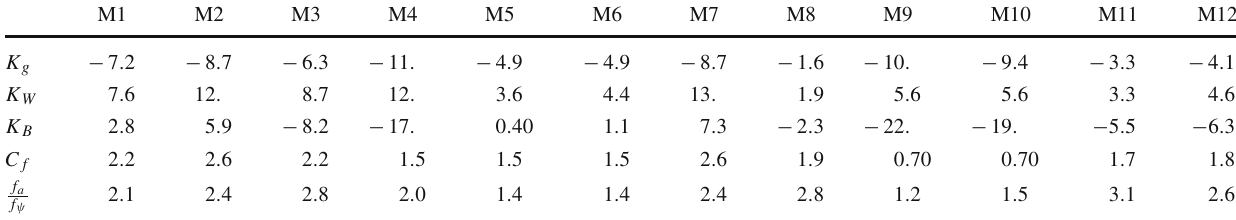
Table 1 Couplings in the twelve models [15] used as benchmarks. For the top, several possibilities arise depending on the choice of top part- ner representation: here, as an illustration, we take the same coupling